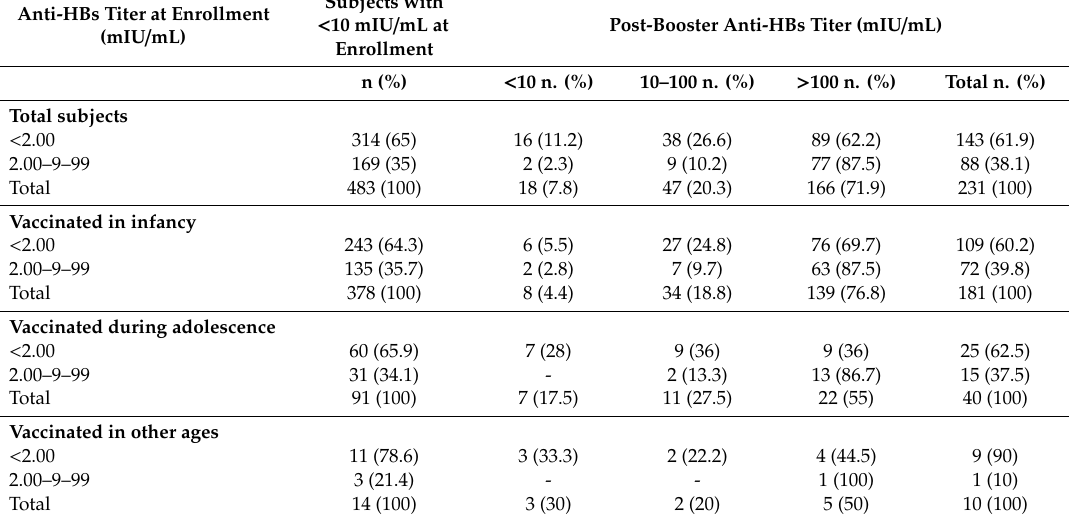
Table 2. Booster dose response stratified by the pre-booster anti-Hbs titer. Anti-HBs Titer at Enrollment (mIU / mL)